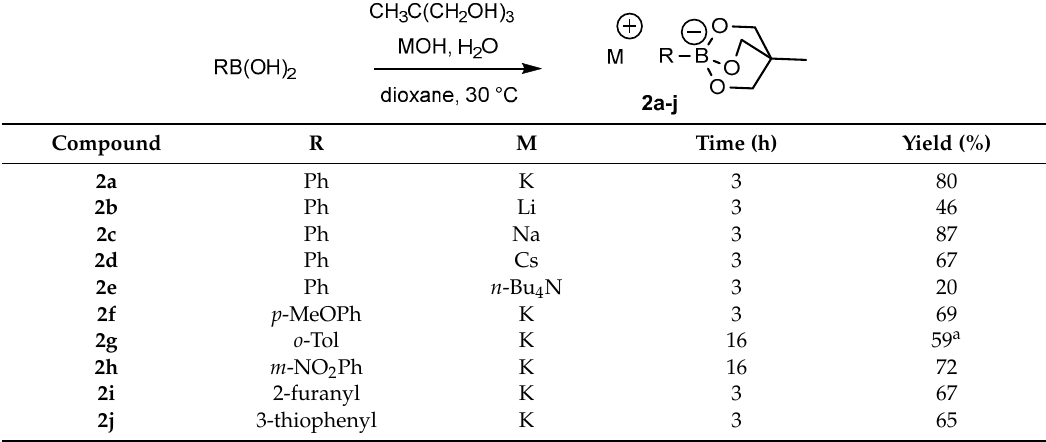
Figure 3. Reactivity of cyclic phenyltriolborate with selected water-soluble aryl halides. Aryl halide (1 equiv.), cyclic triol phenylborate (3 equiv.), Pd-Calix-NS (0.005 mol%), phosphate buffer (20 mM, pH = 8), 37 °C 3 h. Isolated yield after chromatographic purification. Table 3. Synthesis of cyclic triolborates from boronic acids.